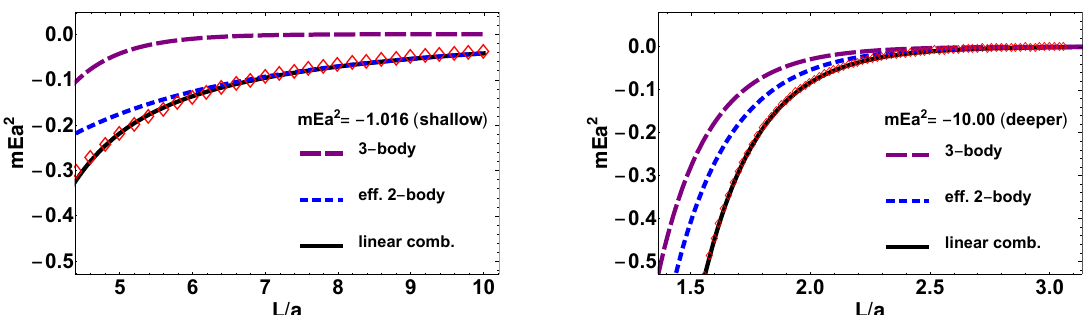
Figure 10: The left plane: energy shift of the shallow bound state. The right plane: energy shift of the deeper bound state.